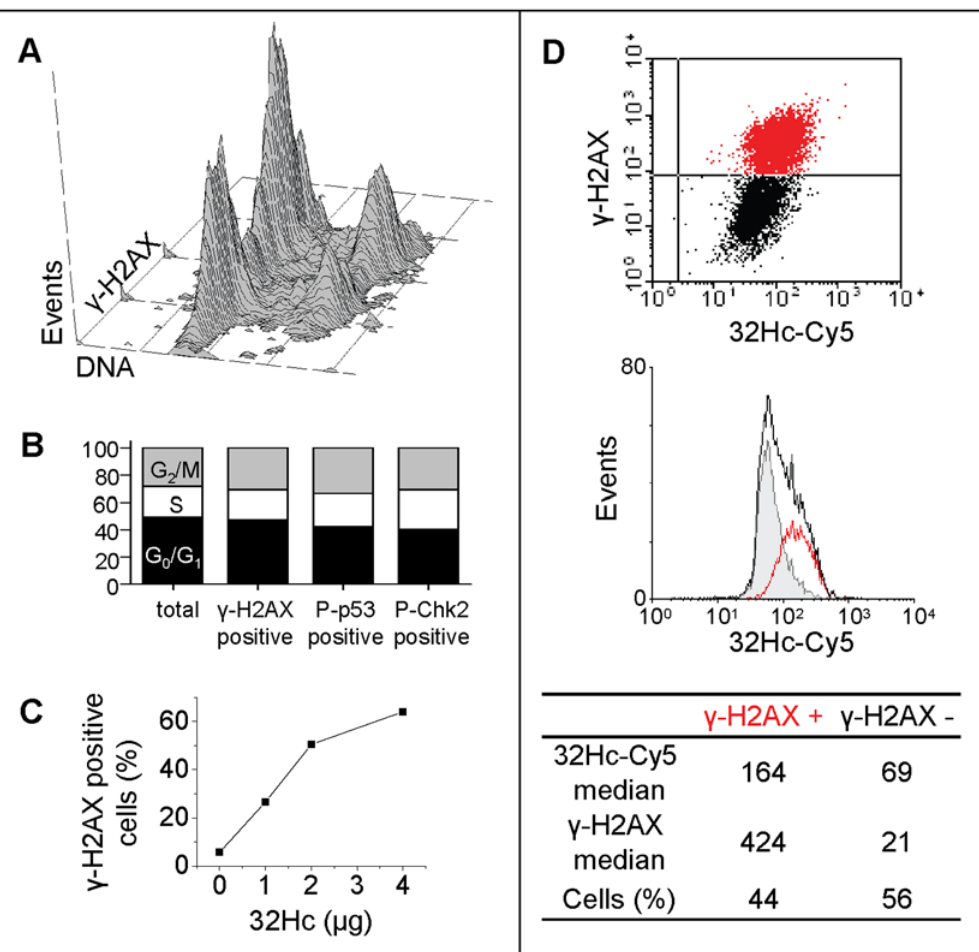
Figure 4. Characteristics of c -H2AX positive cells. Flow cytometry analysis of 32Hc treated MRC-5 cells co-stained for various phosphorylated proteins and DNA content (A) Distribution of the population stained with c -H2AX. (B) quantification of the cell cycle distribution of the total cell population and the c -H2AX, P-p53 or P-Chk2 ‘‘positive’’ subpopulation of the indicated proteins. (C) Percentage of c -H2AX positive cells in the population (as quantified by flow cytometry) after transfection with varying amounts of 32Hc. (D) Dotplot of cells transfected with Cy5-conjugated 32Hc and immunostained for c -H2AX (upper panel). Lower panel: 32Hc-Cy5 distribution in the cell population (black) with superposed subpopulations gated for c -H2AX negative (gray) and positive (red) cells.